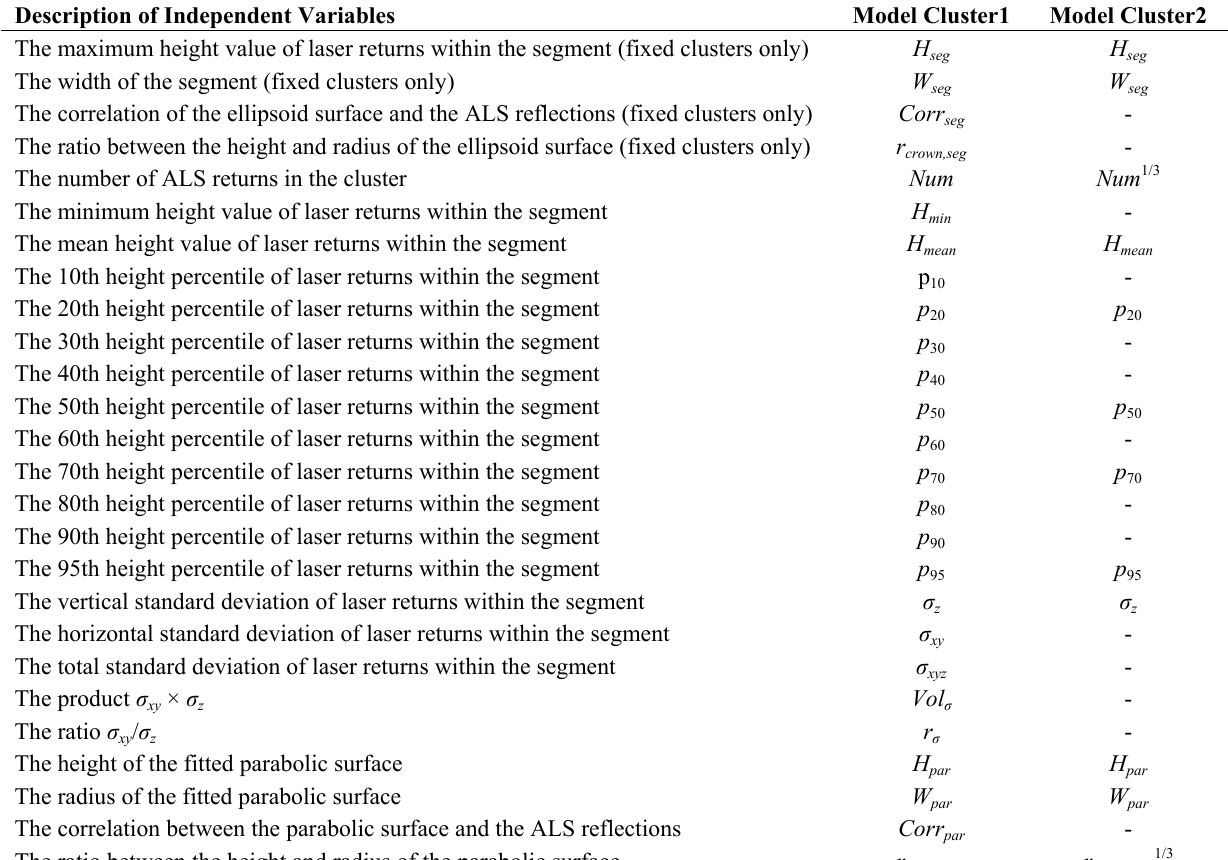
Table 2. Independent variables derived from the